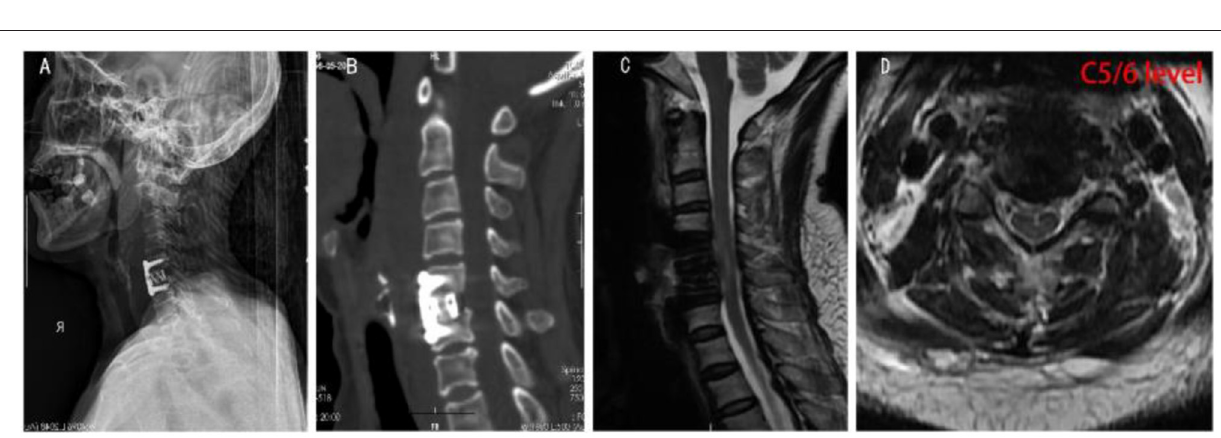
of the implants. Somatosensory evoked potential (SEP)